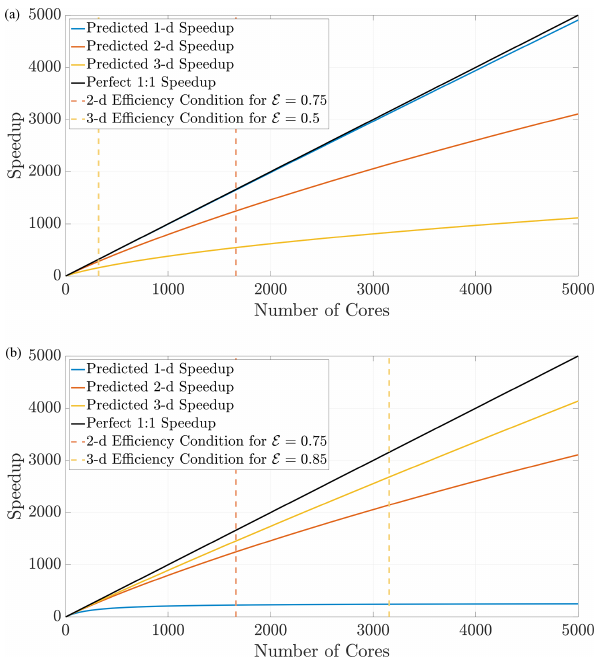
Figure 11. The prediction curves give the user a concrete guide- line to determine how many cores to allocate for a simulation be- fore performance degrades. The curves in (a) are generated for the defined search distance ψ in a domain with a constant respective hypervolume V , which implies that each dimension’s length scale is L = V 1 /d . The curves in (b) are generated for the same search distance ψ but with L d -sized domains for fixed length L .